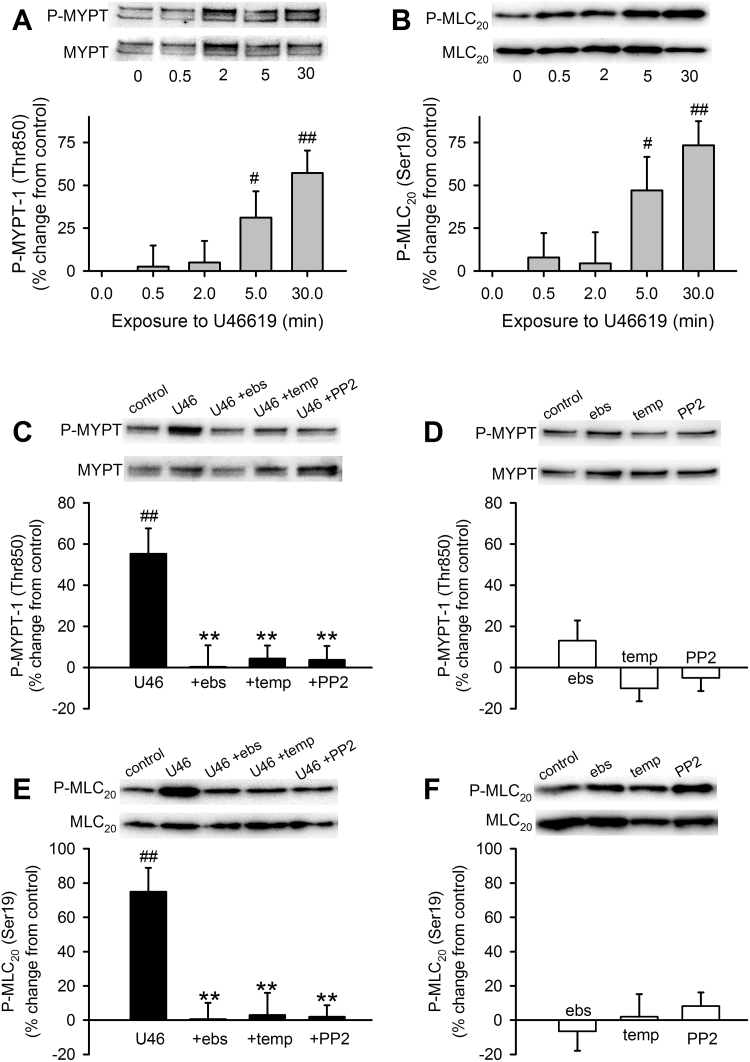
Contribution of ROS and SrcFK to U46619-induced Rho-kinase activity and MLC20 phosphorylation in IPA. U46619 (U46, 100 nM) time-dependently enhances phosphorylation of MYPT-1 on Thr850 (A), and of MLC20 on Ser19 (B), in IPA (n=8–10, #P<0.05 vs. control, ##P<0.001 vs. control, 1-way ANOVA). C: At 30 min, U46619-induced MYPT-1 phosphorylation is inhibited by ebselen (ebs, 10 µM, n=8), Tempol (temp, 3 mM, n=12) and PP2 (30 µM, n=18) ##P<0.001 vs. control (n=27), **P<0.001 vs. U46 alone, while in the absence of U46 (D), MYPT-1 phosphorylation was unaffected by ebselen (n=11), Tempol (n=12) or PP2 (n=18) (2-way ANOVA). E: Similarly, at 30 min, U46619-induced MLC20 phosphorylation is also inhibited by ebs (n=14), temp (n=12) and PP2 (n=17) ##P<0.001 vs. control (n=27), **P<0.001 vs. U46 alone, while in the absence of U46 (F), MLC20 phosphorylation is unaffected by ebselen (n=13), Tempol (n=12) or PP2 (n=18) (2-way ANOVA).